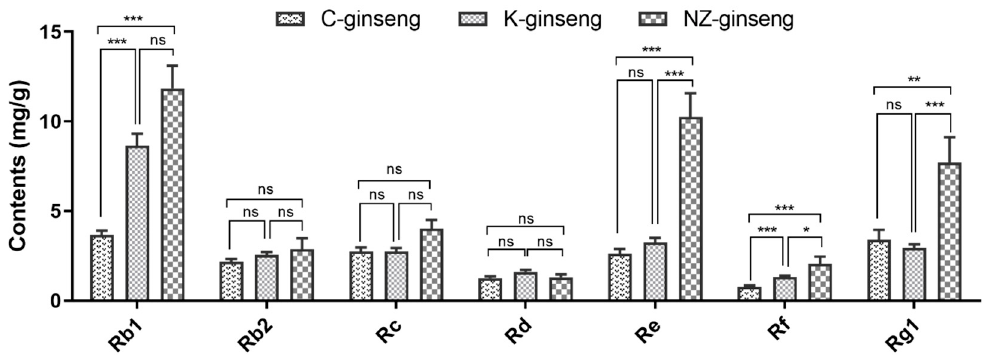
Figure 4. The average content of individual ginsenosides in the ginseng roots grown in three different countries. Data were analyzed by one-way ANOVA using Graph pad prism 6 software and expressed as mean ± SE. * p < 0.05, ** p < 0.01, *** p < 0.001. Differences were considered significant if p < 0.05. C, K, and NZ-ginseng refers to China (n = 113), Korea (n = 106), and New Zealand (n = 14) grown ginseng, respectively.